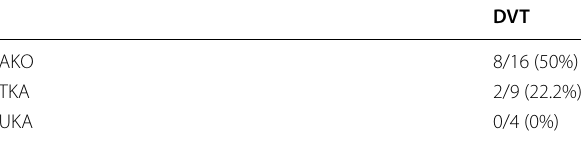
Table 3 The incidence of DVT by procedure (number (%))